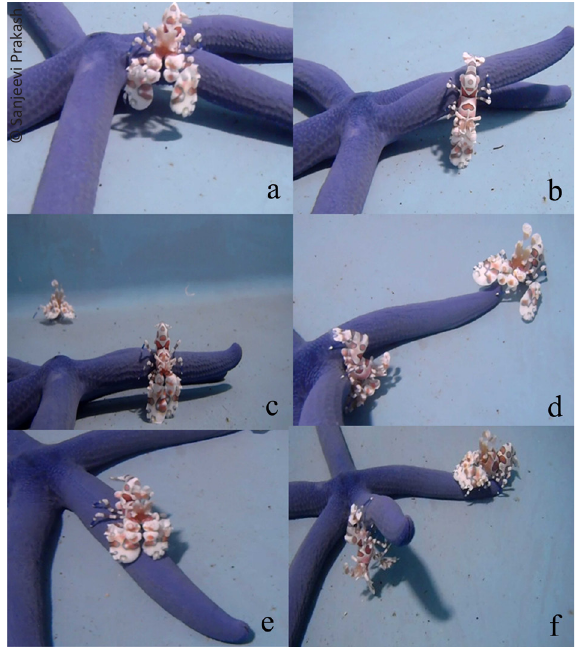
Image 2. Harlequin Shrimp Hymenocera picta feeding on Blue Star Linckia laevigata . a - Smaller male senses and approaches the prey; b - trying to lift the prey; c - larger female stays in a position to move around; d - female approaching the prey and male piercing the tube feet; e - smaller male moving around the edges; f - upliftment of prey